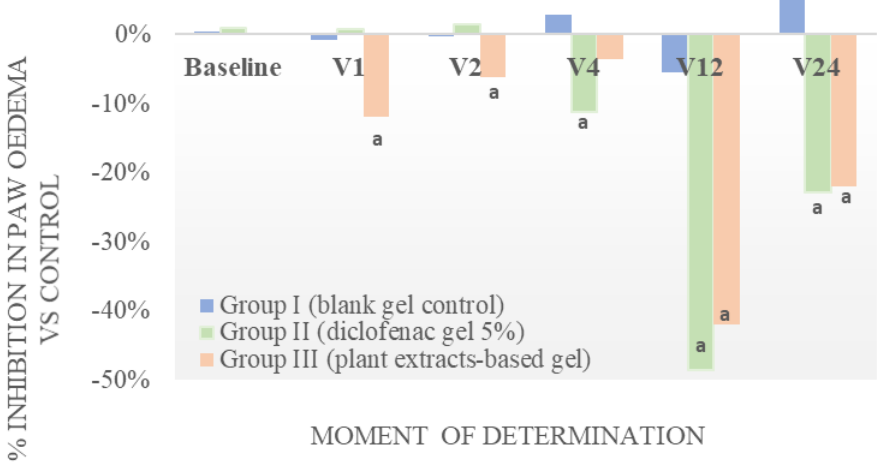
Figure 2. Evaluation of anti-inflammatory effect of the tested gel on kaolin-induced paw oedema in rats vs. control. a Significantly different from control (all p < 0.01, paired tTest Student, CI = 95%).